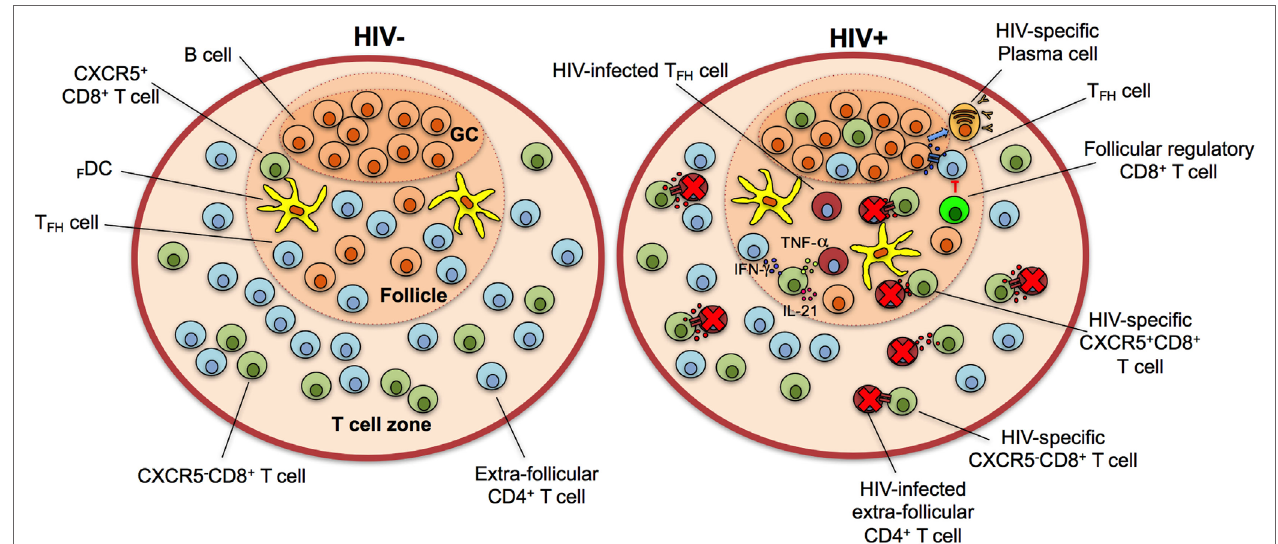
FigURe 3 | CXCR5 + CD8 + T cells control human immunodeficiency virus (HIV) infection in the lymphoid follicle. In HIV-negative individuals, the majority of CD8 + T cells localize in the T cell zone, with a minor fraction present in the lymphoid follicle. During HIV infection, the population of CXCR5 + CD8 + T cells increases in lymphoid follicles and GCs and Ag-specific cytotoxic cells eliminate infected follicular helper T cells (T FH ) cells through the release of cytotoxic granules and/or receptor-mediated apoptosis. They also secrete interferon (IFN)- γ , tumor necrosis factor (TNF)- α , and interleukin (IL)-21 to stimulate T FH and B cells and contribute to an antiviral state. Follicular regulatory cytotoxic cells possibly inhibit T FH cells, which in turn provide stimuli to B cells for their differentiation to HIV-specific plasma cells with production of high-affinity, isotype class-switched antibodies. Note that the frequency of HIV-infected but not eliminated cells is higher in the follicle in comparison with extra-follicular areas. GC, germinal